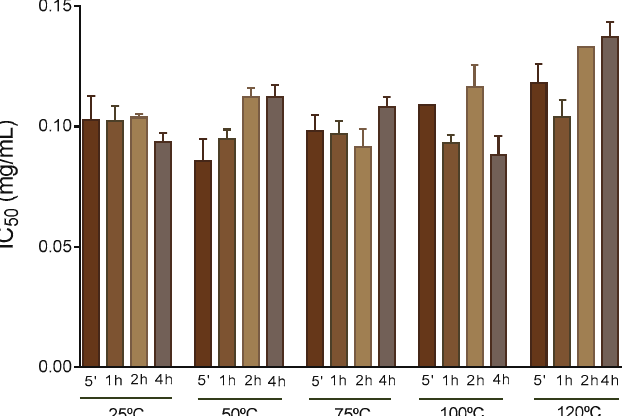
Figure 5. ABTS • + scavenging ability of aqueous extract obtained at 25, 50, 75, 100, and 120 ◦ C between Figure 5. ABTS •+ scavenging ability of aqueous extract obtained at 25, 50, 75, 100, and 120 °C between 5 min and 4 h, expressed in IC 50 (mg / mL of 5 min and 4 h, expressed in IC 50 (mg/mL of extract).